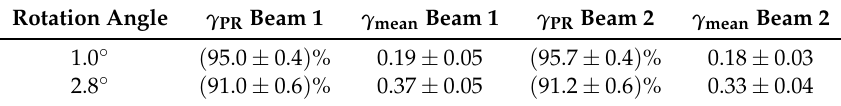
Table 2. Results of the gamma-index comparison for phantom